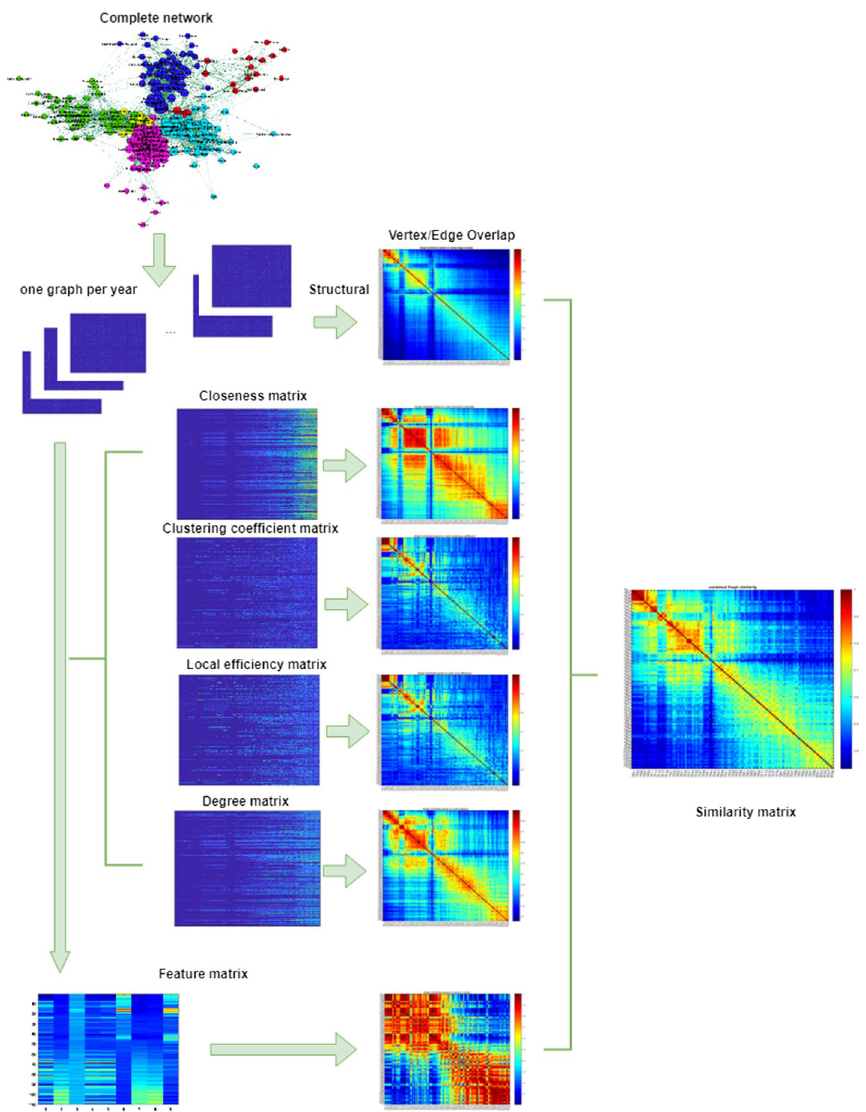
Fig. 12 Pipeline for identifying temporal states in football history. 110 networks are generated for each year from 1901 to 2010. Node-level, graph-level, structure-level similarity matrices are computed and the final similarity matrix is given on the